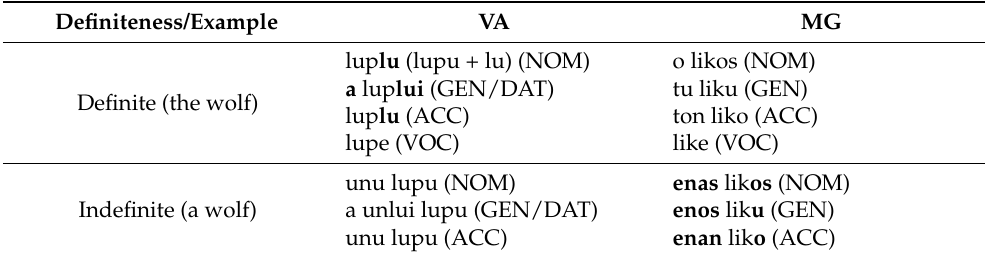
Table 1. Definiteness marking in MG and VA.